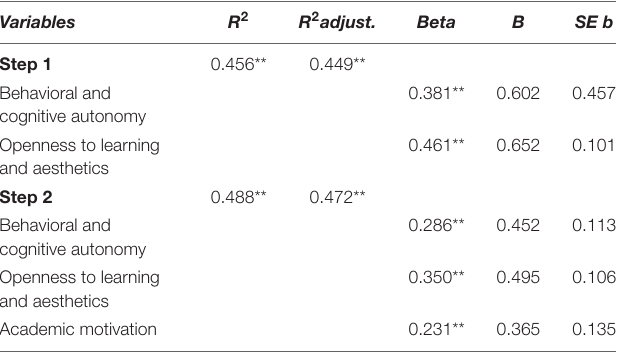
TABLE 4 | Hierarchical multiple regression analysis of explanatory factors of well-being (positive attitude toward self, others, and student